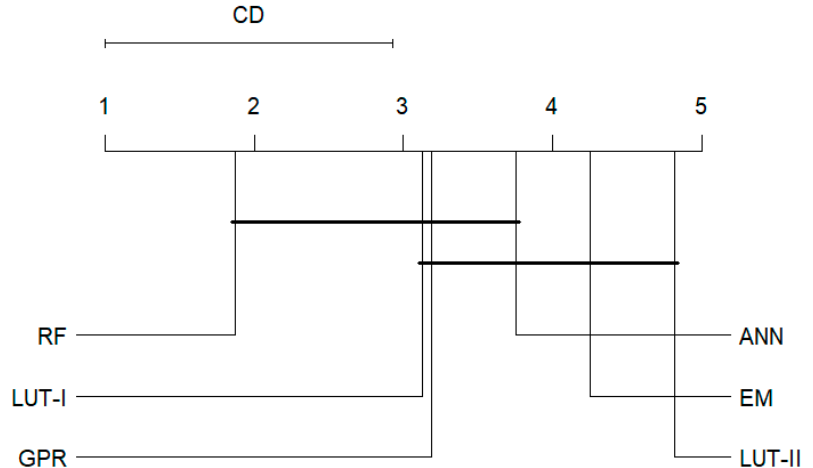
Figure 6. Critical distance diagram of the inversion methods performance for LAI estimation. The groups of the inversion methods that are not significantly different are connected with black line ( p - value > 0.05).